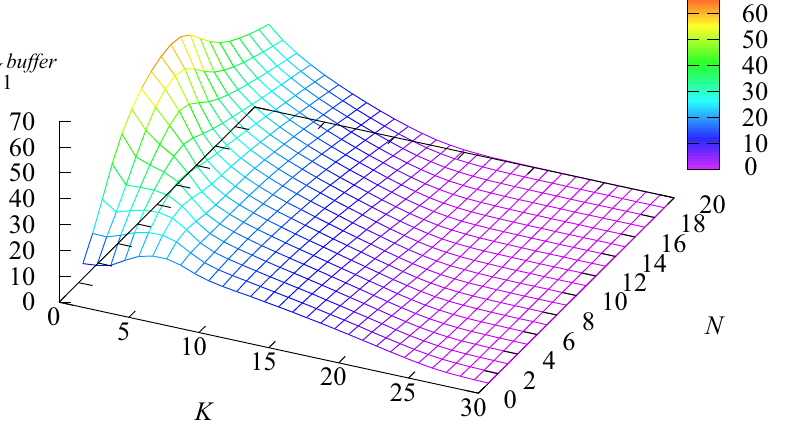
Figure 4. Dependence of the average number N buf fer parameters N and K